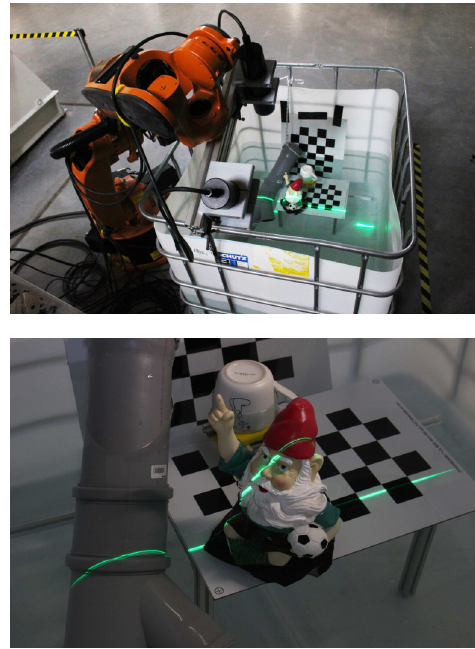
Figure 7. Top: Scanning a semi-submerged scene with the scanner mounted to an industrial manipulator. Bottom: Detail view of the captured scene with a laser line projected by the